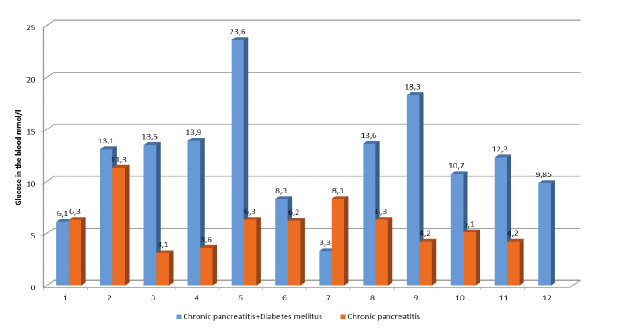
Figure 2 - Fluctuations in blood sugar